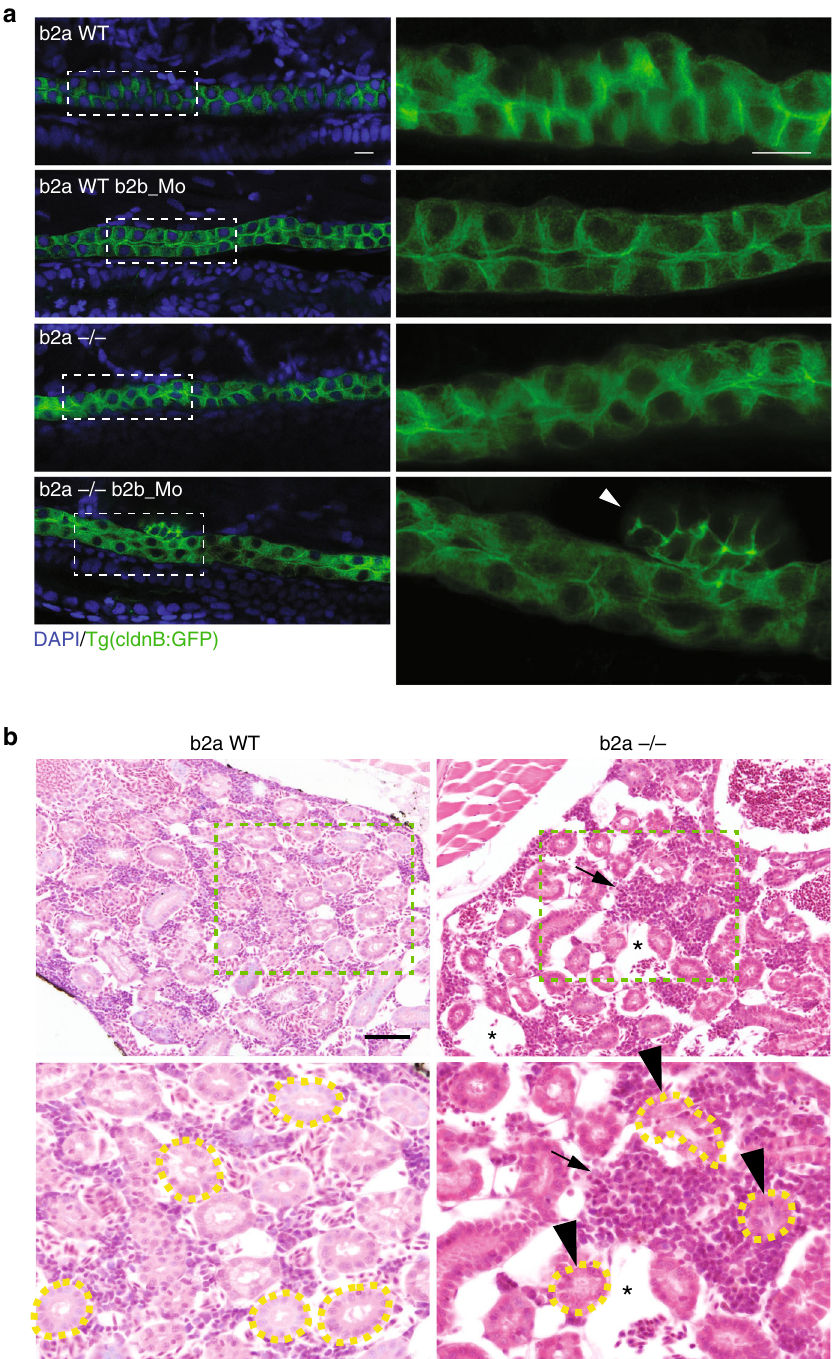
Fig. 8 Loss of IRSp53 causes defects in pro-nephric ducts and in adult kidneys in zebra fi sh. a Digital light sheet confocal images of 72 hpf pronephric ducts. Embryos obtained from either wild-type (b2a WT) or baiap2a (b2a − / − ) mutant females in a Tg(CldnB:GFP) genetic background were treated with scrambled morpholino (b2a WT; b2a − / − ) or with spliced and translation blocking morpholinos (b2a WT b2b_Mo; b2a − / − b2b_Mo), and fi xed and mounted in agarose. Samples were stained with an anti-GFP antibody (green) and DAPI (blue). Z-stack projections (magni fi cation, 3.4×) are shown on the right for the dashed, rectangular boxes on the left. Arrowhead, extra-duct structure in the b2a − / − b2b_Mo embryo. Scale bars, 10 µ m. Two-thirds of the b2a − / − b2b_Mo embryos showed such defects ( n = 8/12). b ) Hematoxylin and eosin staining of adult zebra fi sh kidneys. Adult wild-type (b2a WT) and b2a − / − strains were fi xed, decalci fi ed, and paraf fi n embedded. Bottom: Magni fi cation (2×) of the light green dashed boxes from the upper images. Renal tubules are surrounded by yellow dashed lines. Arrowheads, abnormal disarrayed and not patent tubules in the b2a − / − sample, characterized by the irregular distribution and shape of the nuclei; asterisks, vascular lacunae; arrows, in fi ltrating cells. In all, 70% of the b2a − / − samples show such defects ( n = 7/10) versus ~10% of the b2a wild-type ( n = 1/9). Scale bar, 50 µ